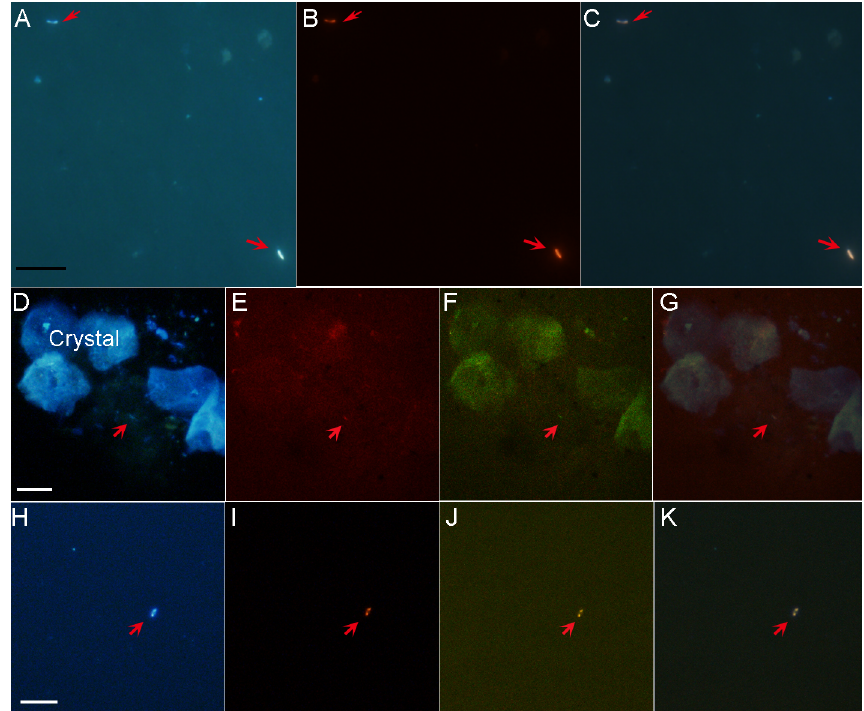
Figure 7. Fluorescence in situ hybridization (FISH) of Alcanivorax borkumensis ABS183 embedded in anhydrite crystals. DAPI staining and FISH using 16S rRNA probes are shown in (a) and (b) . The merged image of (a) and (b) is shown in Fig. 7c. DAPI staining and FISH were also performed using two samples that were filtered with 3µm (d–g) and 0.22µm (h–k) membranes, respectively. Alcanivorax bacteria were released from the large crystals filtered through the 3µm membranes (d–g) . The bacteria were stained with DAPI (d) , Alcanivorax borkumensis ABS183 probes (f) and the alkB probe (f) , respectively, and overlaid (g) . Using a sample filtered through a 0.22µm membrane, a dividing Alcanivorax borkumensis ABS183 cell was labeled using the same method and probes (h–j) . The microscopic fields shown in (h) – (j) are merged in (k)